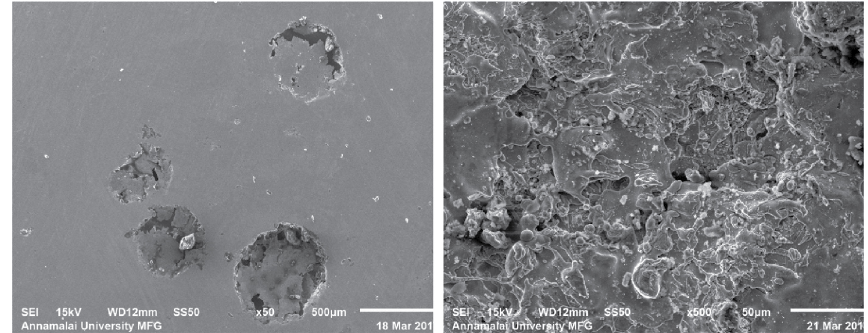
Figure 10: Surface morphologies after potentiodynamic polarisation in 3.5 (wt.%) NaCl solution (A) uncoated AISI 316 stainless steel specimen (B) HVOF sprayed Fe-based amorphous coated specimen.